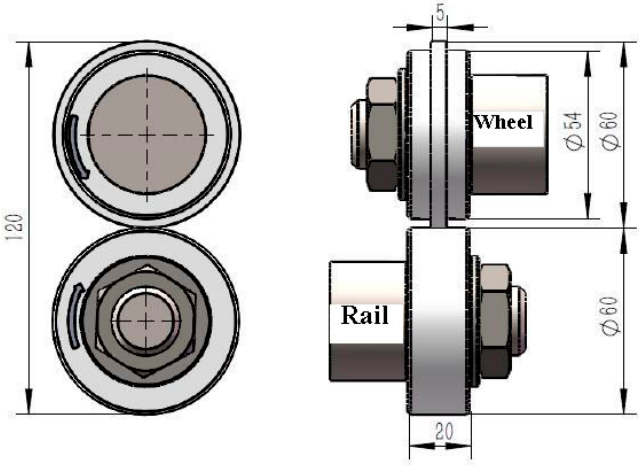
Figure 3. Sample dimensions and contact mode of wheel and rail samples (unit: mm) [15]. Table 1. Chemical compositions of the samples (wt %).